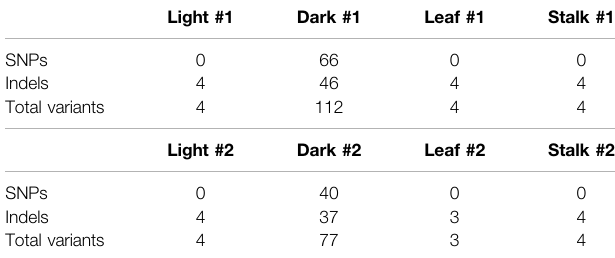
TABLE 1 | DRAGEN variant analysis — the number of Indels/SNPs in each ptDNA